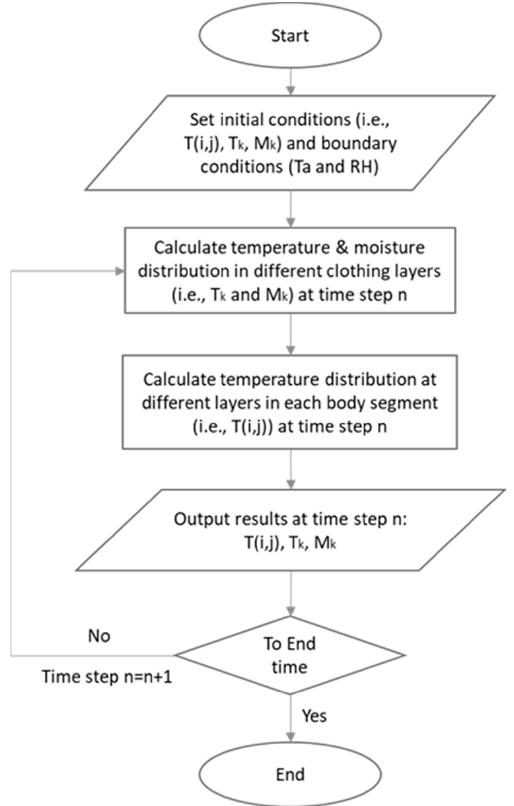
Figure 3. Flow chart showing the operation sequence of the new HPCS model.